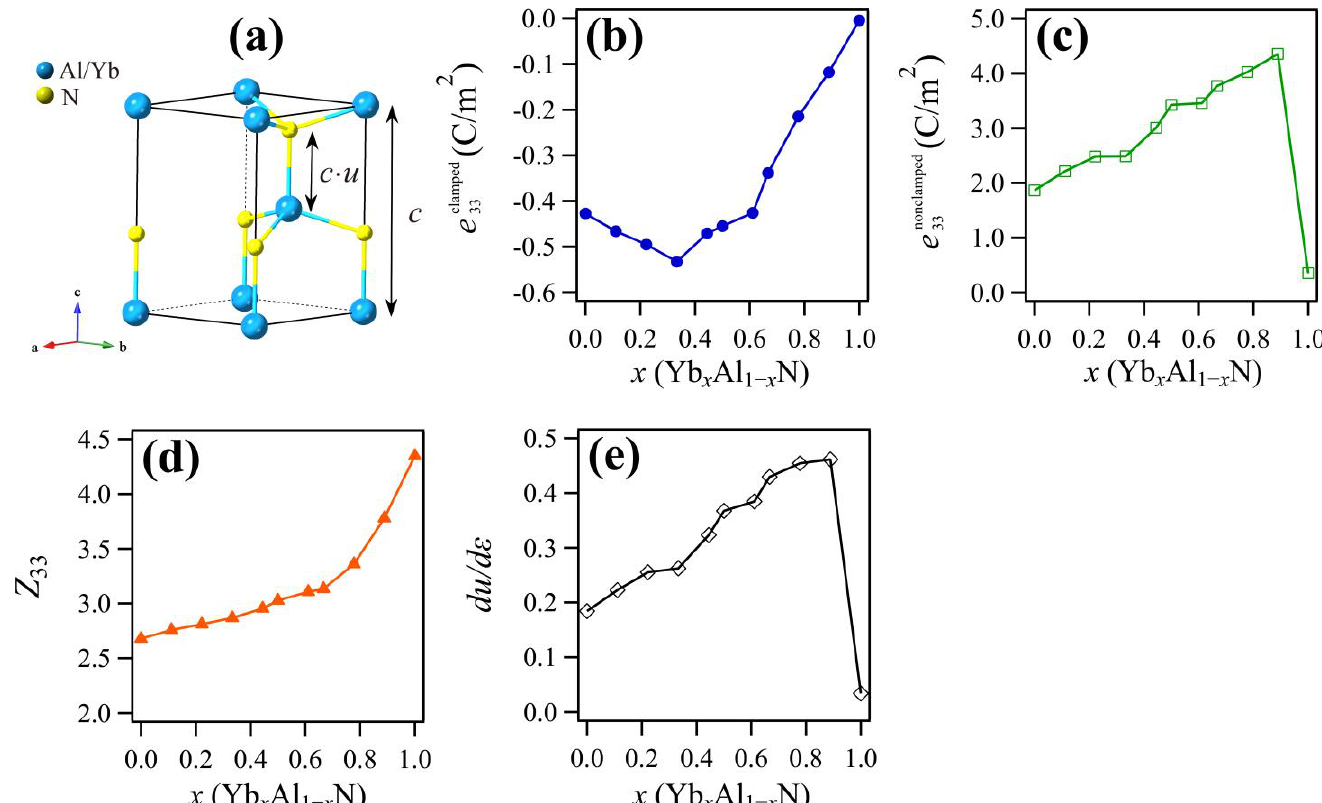
Figure 5. ( a ) Crystal structure of wurtzite showing the internal parameter, u . Blue and yellow spheres represent Al/Yb and N atoms, respectively. Other changes to the component values of e 33 as a function of Yb content; ( b ) clamped e 33 ; ( c ) nonclamped e 33 ; ( d ) components of the nonclamped Born effective charge, Z 33 ; and ( e ) the strain sensitivity of the internal parameter, du/d ε